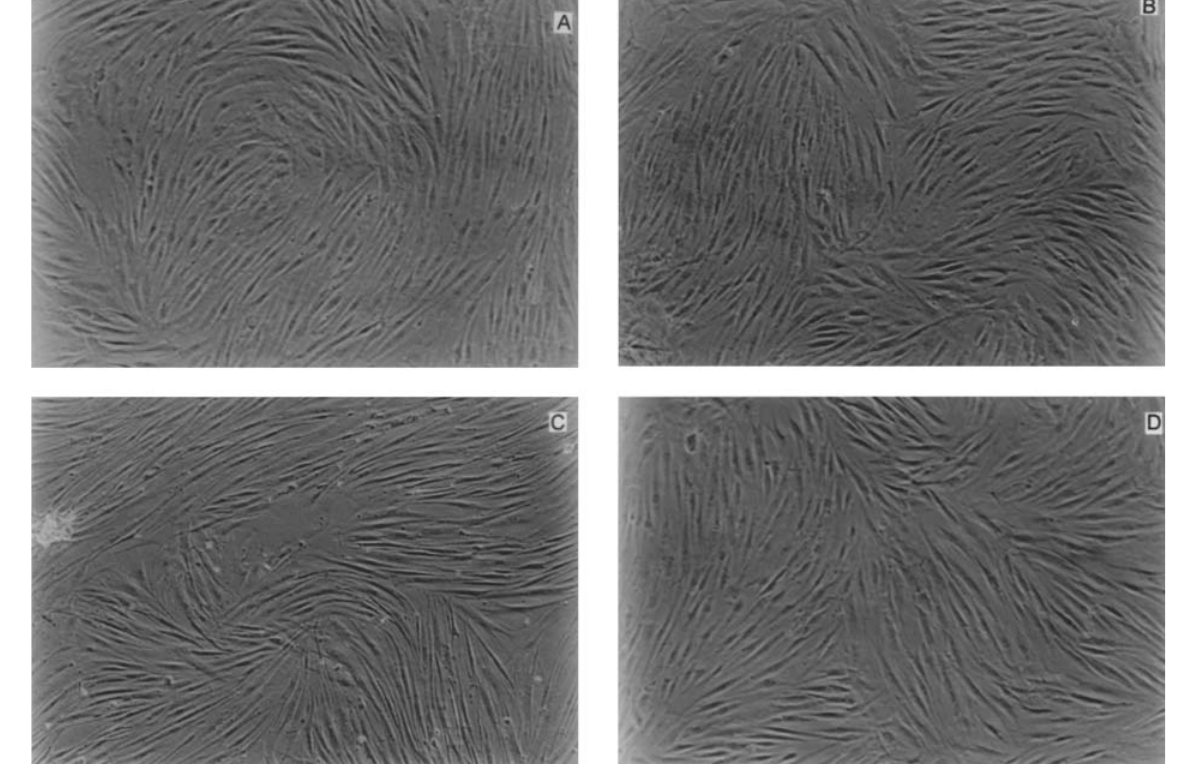
Figure 1 - Photograph of fibroblasts without (a) and after amikacin 11 µ g/mL (b), 22 µ g/mL (c) and 33 µ g/mL (d) addition. (X